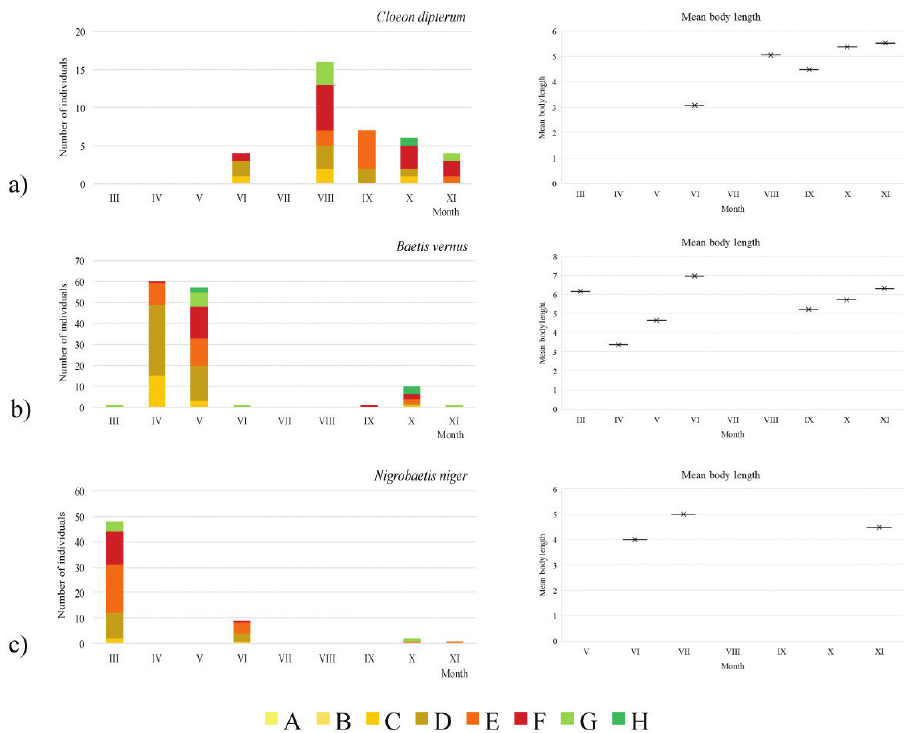
Figure 4. Seasonal dynamics of a Cloeon dipterum in the Đon močvar peat bog and b Baetis vernus c Nigrobaetis niger in adjacent Daković klada Stream between March and November 2015. Legend: Body length category: A = 0.00–0.99 mm; B = 1.00–1.99 mm; C = 2.00–2.99 mm; D = 3.00–3.99 mm; E = 4.00–4.99 mm; F = 5.00–5.99 mm; G = 6.00–6.99 mm; H = 7.00–7.99